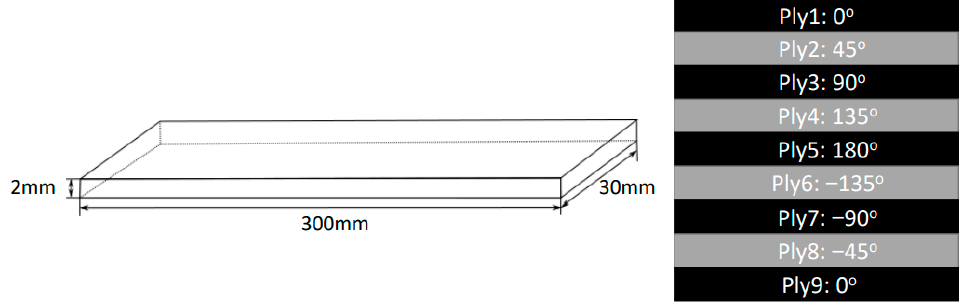
Figure 5. Dimensions and stacking sequence of the multidirectional CFRP − 135/ − 90/ − 45/0]